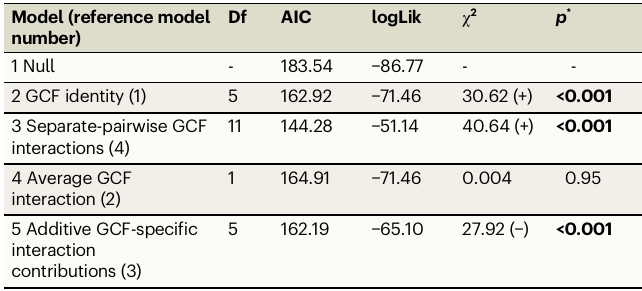
Table 1 | Contributions of GCF identities and GCF interactions to GCF-number effects on the aboveground biomass of the transplanted-seedling communities Model (reference model number)